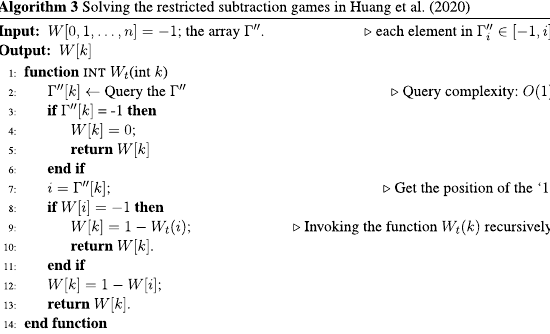
Algorithm design: According to the characteristics of the